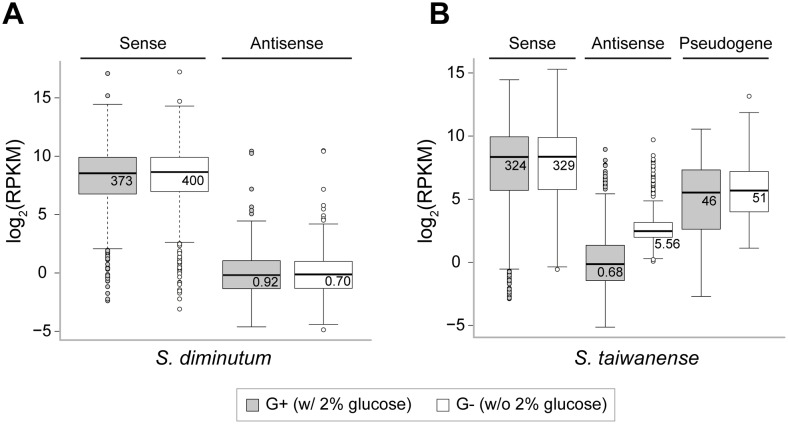
—Distribution of the RPKM values observed. (A) Spiroplasma diminutum. (B) Spiroplasma taiwanense. The median values prior to log-transformation are labeled. The inner fence values (i.e., ends of the whiskers) represent the lowest value within 1.5 interquartile range of the lower quartile and the highest value within 1.5 interquartile range of the upper quartile.